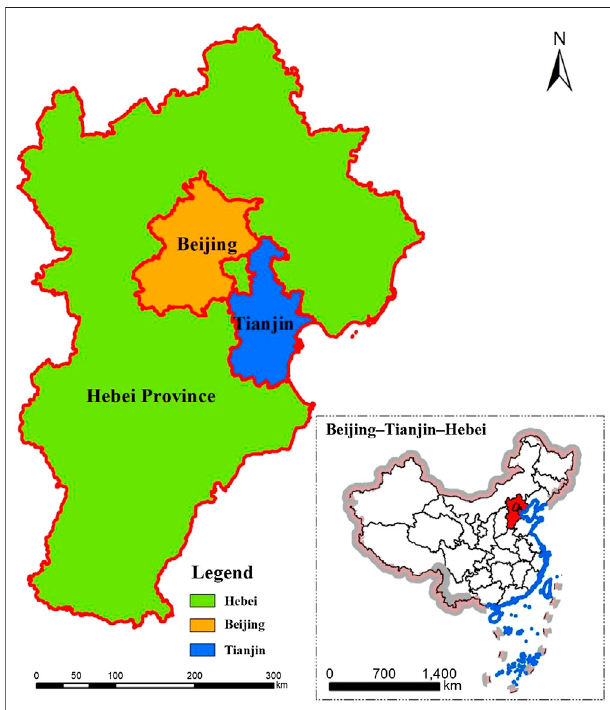
FIGURE 1 | The location of the study region in